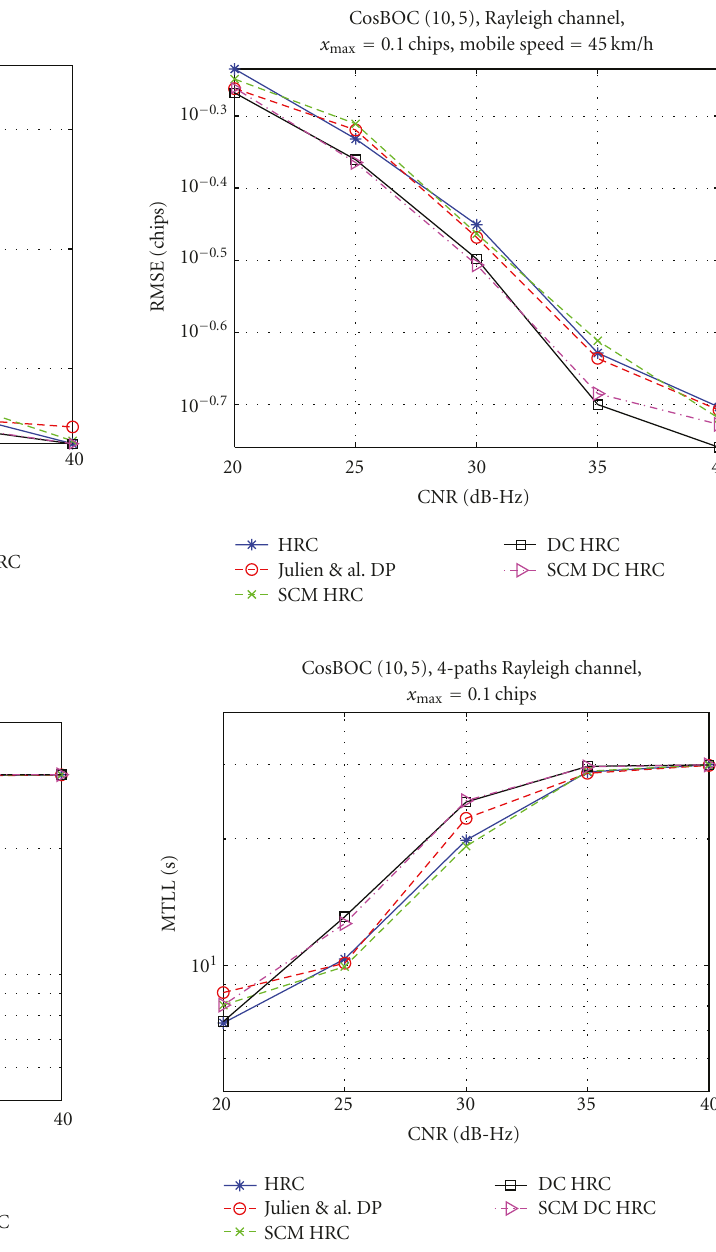
Figure 21: Comparison of feedback delays estimation algorithms employing the HRC discriminator and of the Julien&al. method, as a function of CNR; CosBOC(10,5) modulation, 4-paths Rayleigh channel, with paths PDP of − 1, − 2, 0, and − 3dB, v = 45km/h, closely spaced paths x max = 0 . 1